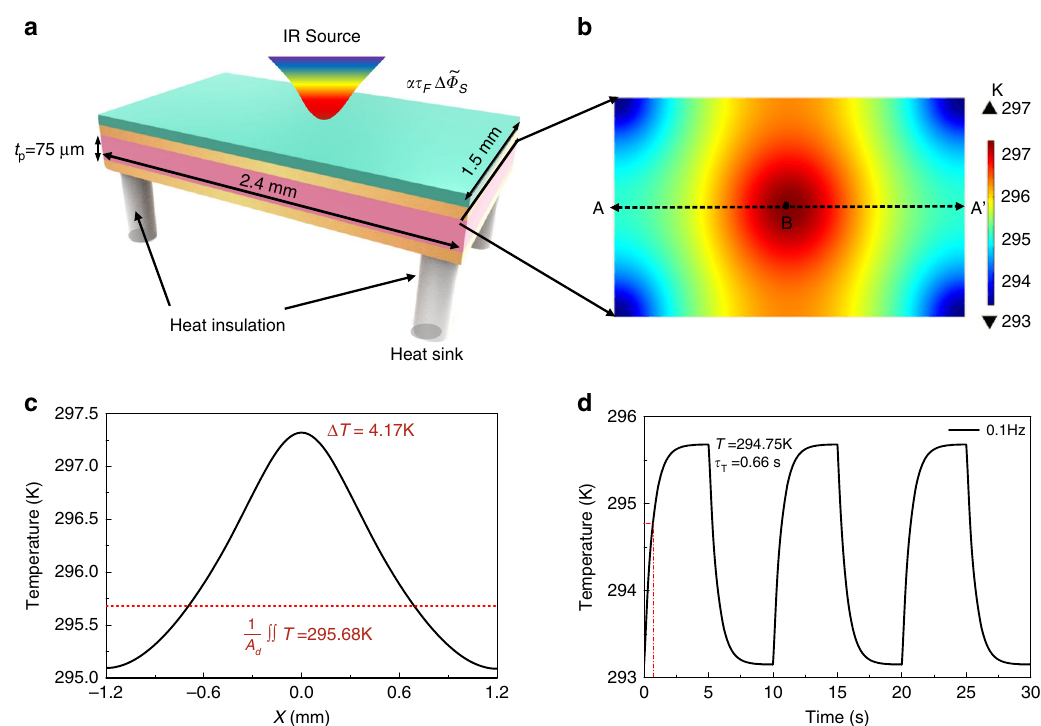
Fig. 3 The thermal analysis of the pyroelectric detector. a The schematic diagram of the suspended LT substrate used for calculating the steady-state temperature distribution and the dynamic temperature change in the time-domain. b The steady-state temperature distribution at the surface of the LT layer. c The steady-state temperature distribution along the cut line A-A ’ . The red dotted line indicates that the average temperature is 295.68 K. d The time-domain average temperature at the upper surface of the LT substrate assuming that the power is modulated by a square wave with the frequency of 0.1 Hz. Source data are provided as a Source Data fi